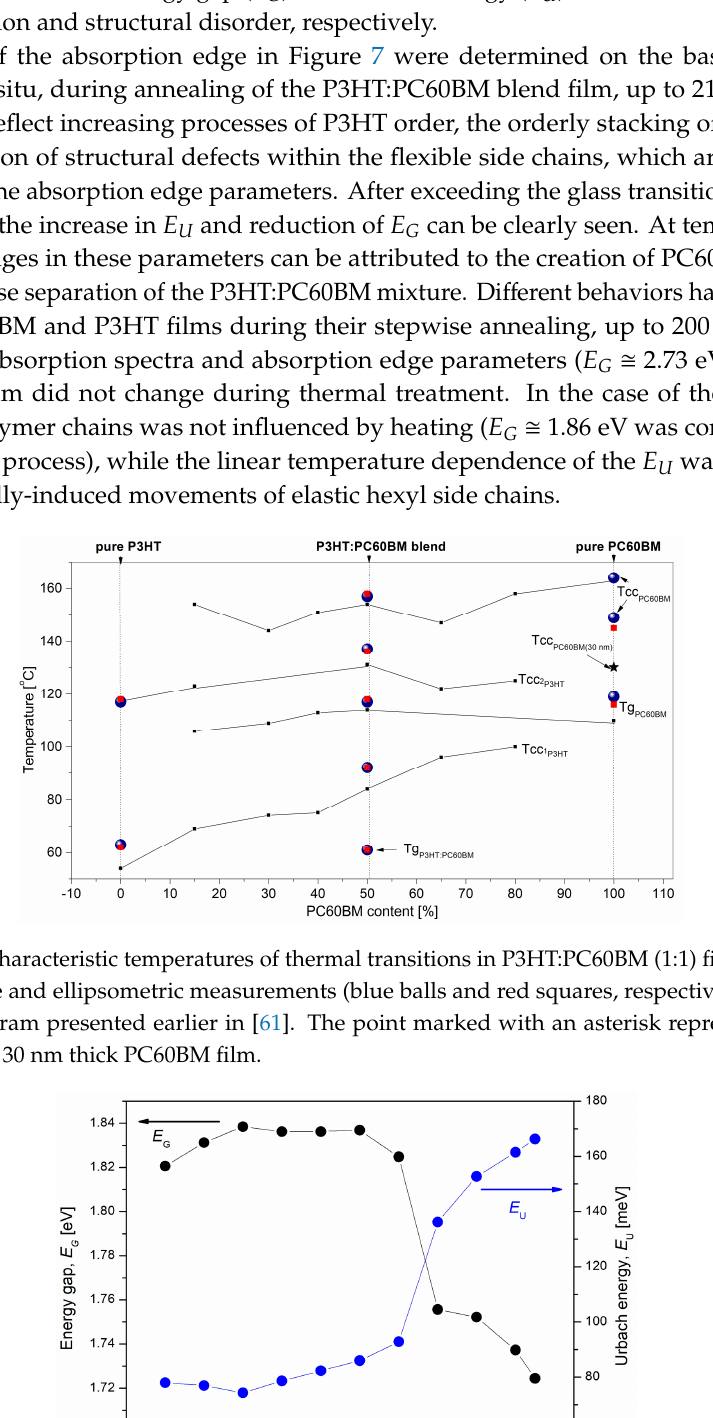
Figure 7. The absorption edge parameters: the energy gap ( E G ) and the Urbach energy ( E U ) as a function of temperature for P3HT:PC60BM film deposited on quartz substrate. Analysis of surface images of samples, obtained with an optical microscope, provides valuable additional information on changes in surface morphology of P3HT and PC60BM. Figures 8 and 9 show a series of surface images taken before and after thermal annealing, allowing for the comparison of the film surfaces of pure P3HT and PC60BM materials, respectively. Further, Figure 10 shows corresponding images for the P3HT:PC60BM blend film. On the surfaces of all the samples,